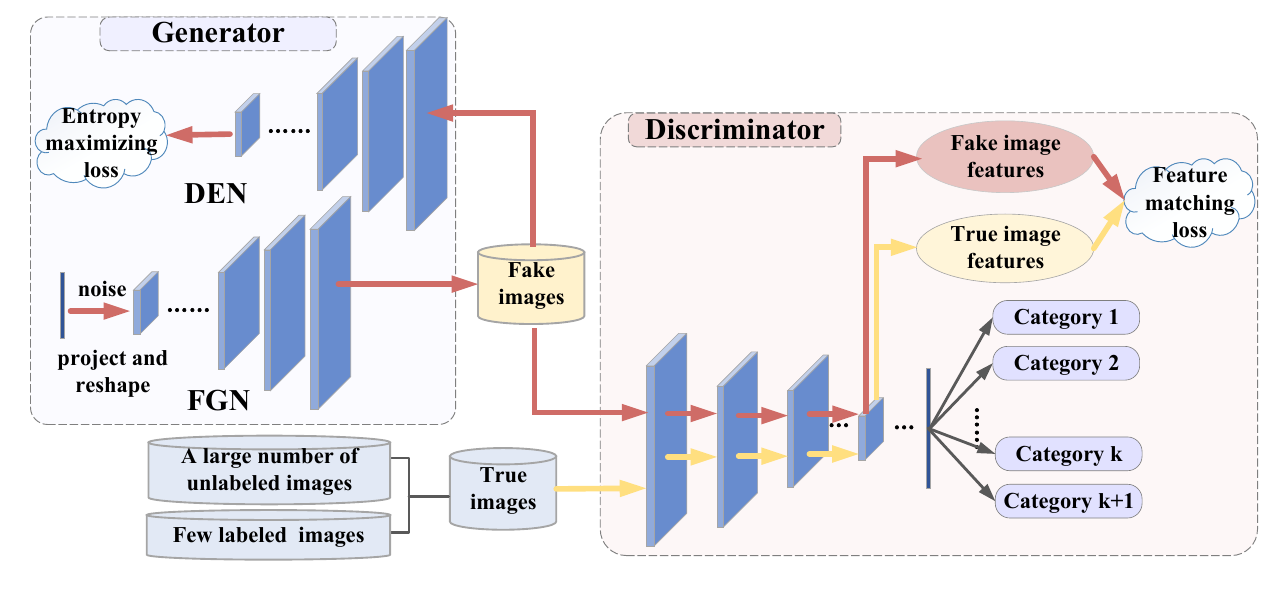
Figure 1. The framework of DEGAN.